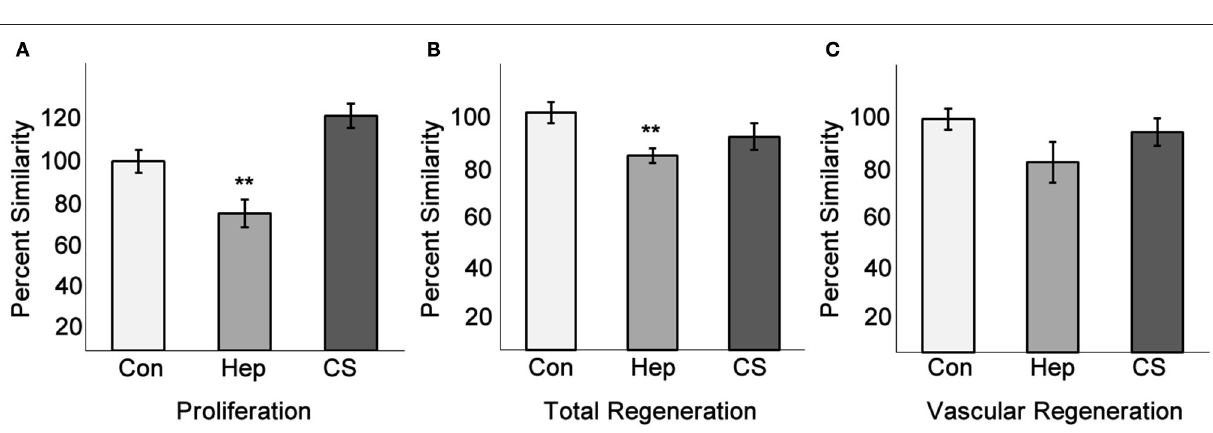
FIGURE 7 | Heparin decreases endothelial cell proliferation and total fin regeneration. Fins injected with phenol red, heparin, or chondroitin sulfate were analyzed for EC proliferation, total regeneration length, and vascular regeneration length as in Figures 5 , 6 . (A) Quantitation of H3P/Fli1 ECs. (B) Quantitation of total regeneration length. (C) Quantitation of vascular regeneration length. Graphs are mean percent similarity ± S.E.M. ** p < 0.01 compared to control. Data are representative of three independent experiments with at least three fish per experimental